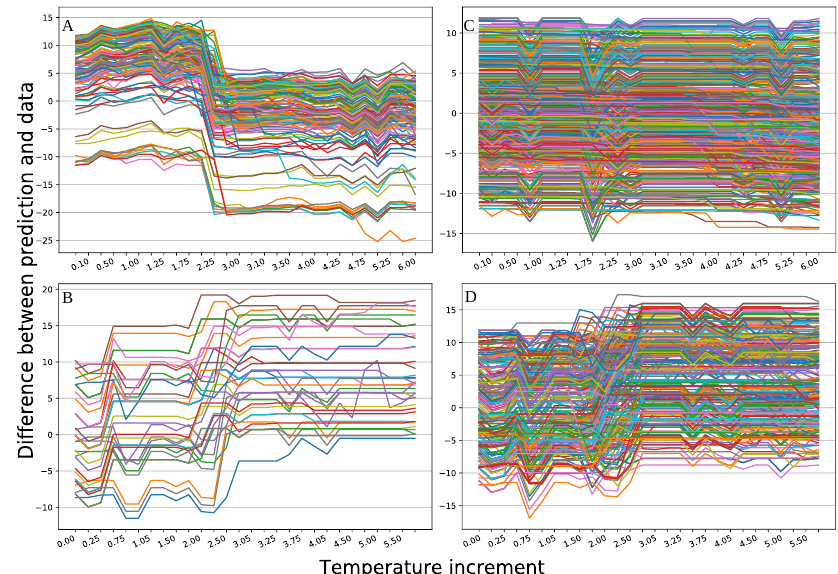
Figure 8. Prediction of time to flowering for samples with an error less then 12 days with increased temperature. The difference between pool prediction and data is plotted against the temperature increment. Lines of different color represent different samples. ( A ) Samples with decreasing time to flowering. ( B ) Samples with increasing time to flowering. ( C ) Samples with variation of time to flowering less than 5. ( D ) Samples with variation of time to flowering greater or equal 5 days and less or equal 10